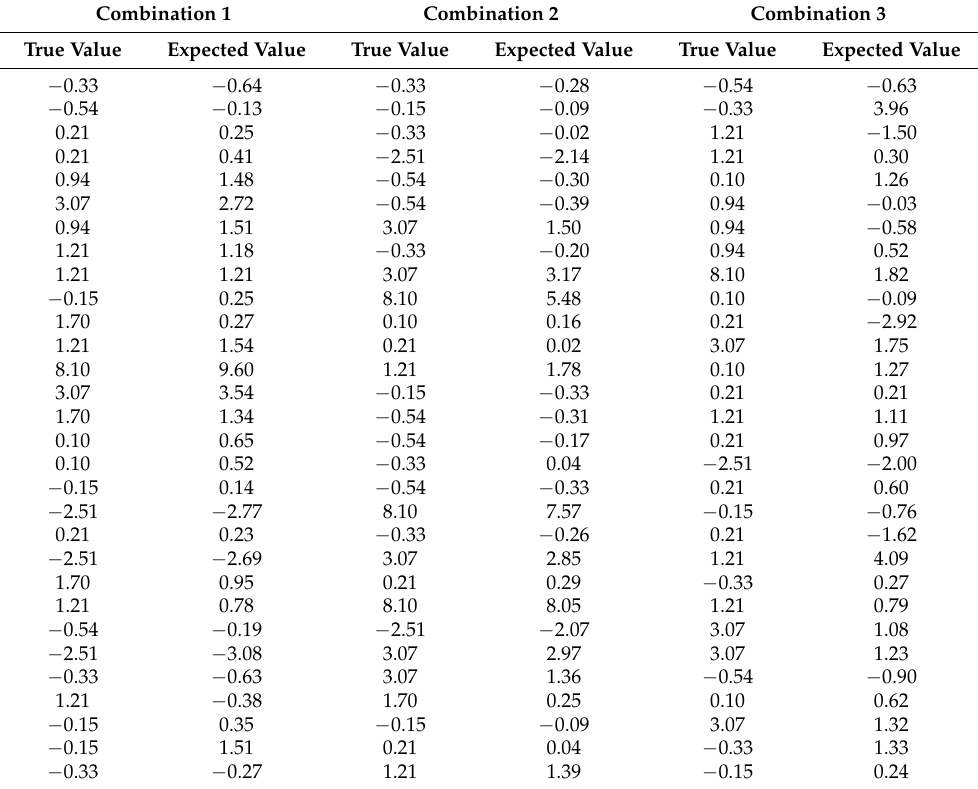
Table 4. Training factor test results for the three combinations.